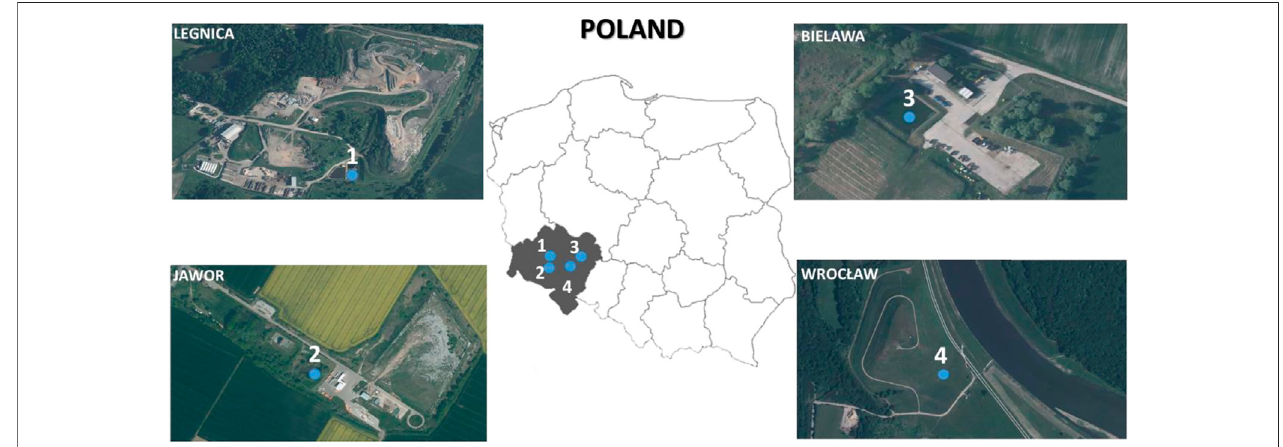
FIGURE 1 | Land fi lls location and placement of water sampling points,